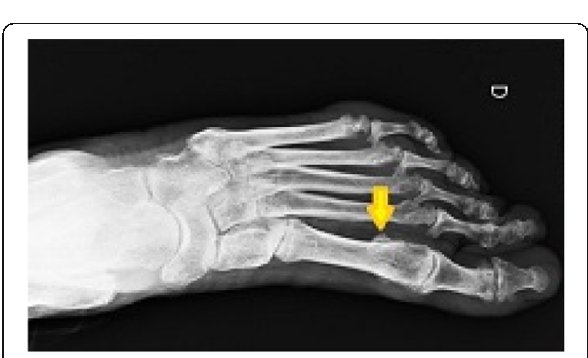
Fig. 3 (abstract P364). Signs of entesopathy of the third left finger nail insertion